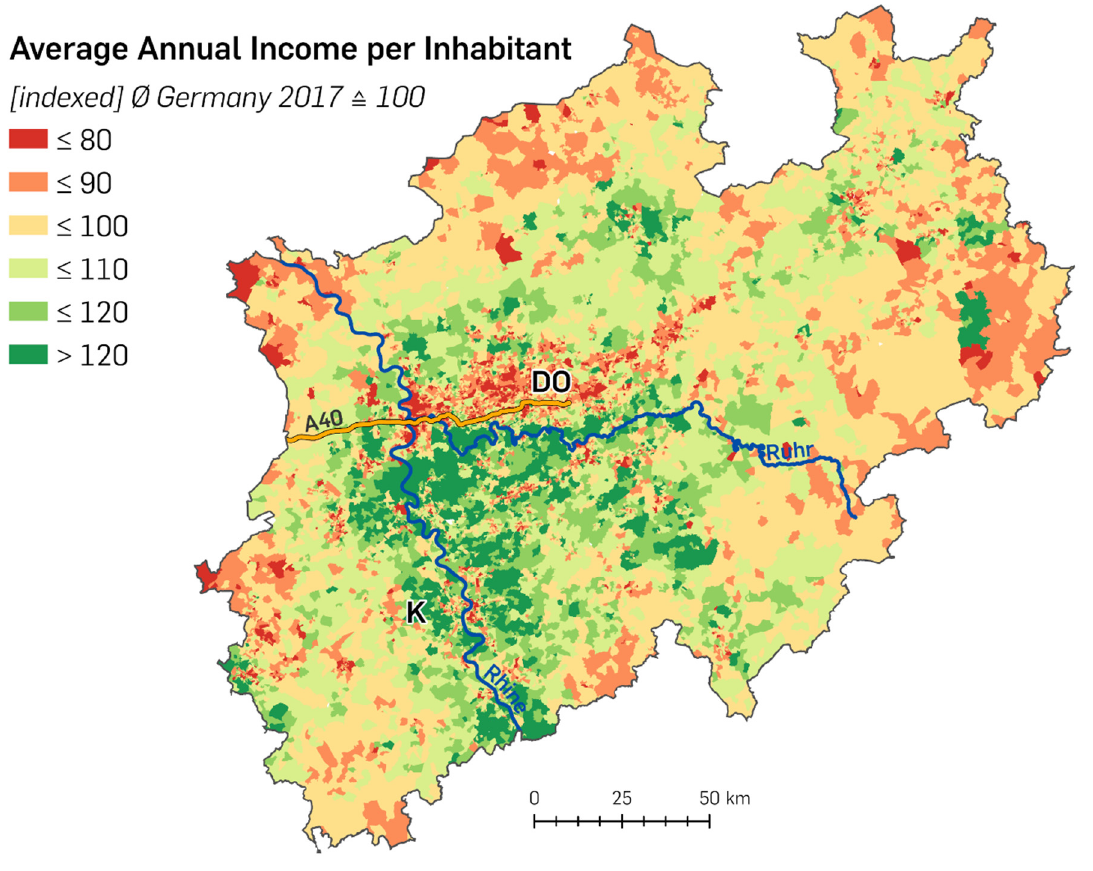
Figure 3. Average annual income per inhabitant (PPI 2017) for the area of North Rhine-Westphalia based on PLZ8 polygons, K: Cologne, DO: Dortmund (Data source: [23,25,26]).